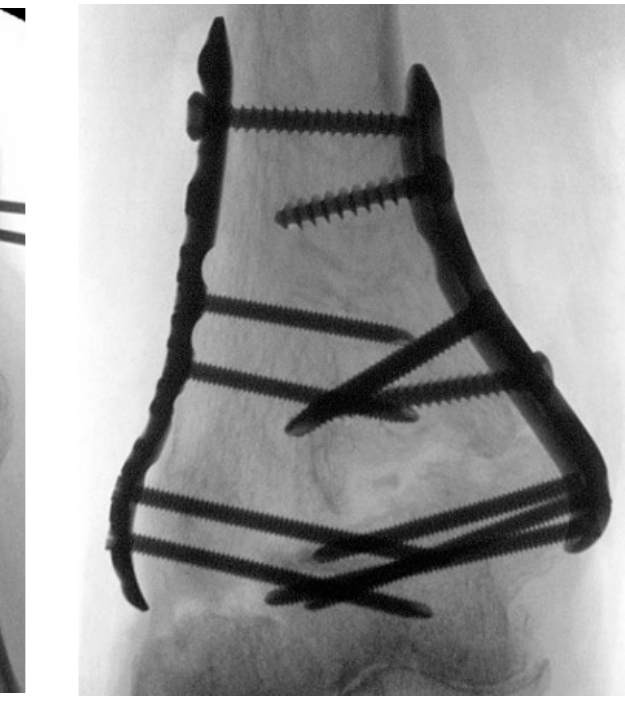
Table 1. Initial patient demographic and surgical